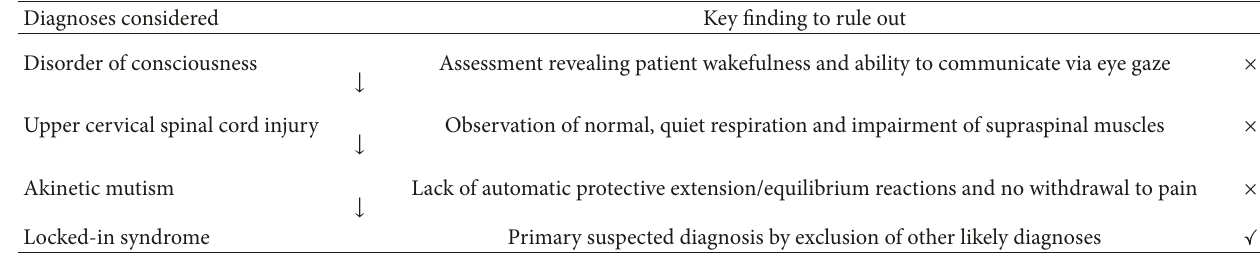
Table 3: Differential diagnosis: acute onset of quadriplegia and mutism.